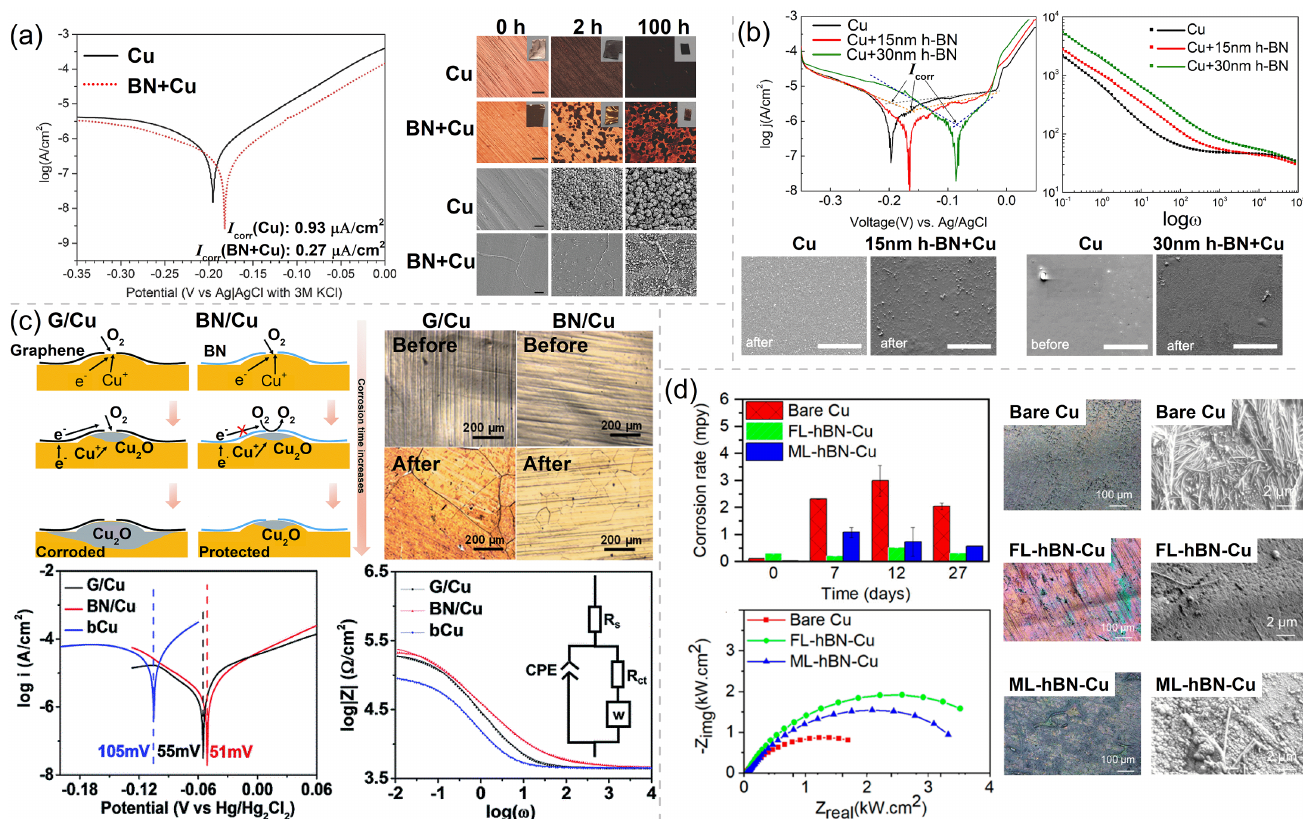
Figure 2. ( a ) The optical microscopy photos of the bare Cu and h-BN/Cu before (0 h) and after heating at 250 ◦ C in air for 2 and 100 h and the Tafel plots of the bare Cu and h-BN/Cu in N 2 -gas bubbled 0.1 M NaCl solution. Adapted with permission from Reference [45]. Copyright 2014, Wiley. ( b ) Tafel plots and Bode plots of uncoated Cu and h-BN/Cu samples in 0.1 M Na 2 SO 4 solution and SEM morphology comparison of bare Cu, 15 nm h-BN/Cu, and 30 nm h-BN/Cu before and after corrosion testing. Adapted with permission from Reference [46]. Copyright 2016, IOP Publishing. ( c ) Schematic diagrams of the corrosion mechanisms for h-BN/Cu and Gr/Cu samples and optical microscopy images of Gr/Cu and BN/Cu before and after 160 days exposure to the ambient environment, and Tafel plots and EIS curves of bare Cu (bCu), G/Cu, and BN/Cu samples. Adapted with permission from Reference [47]. Copyright 2016, The Royal Society of Chemistry. ( d ) Corrosion rates and Nyquist plots of the bare Cu and h-BN/Cu exposed for 27 days and optical images and higher magnification SEM images of bare Cu, few-layer h-BN-coated Cu (FL-hBN-Cu), and multilayer h-BN-coated Cu (ML-hBN-Cu) before and after 48 h of exposure of planktonic cells. Adapted with permission from Reference [48]. Copyright 2020, American Chemical